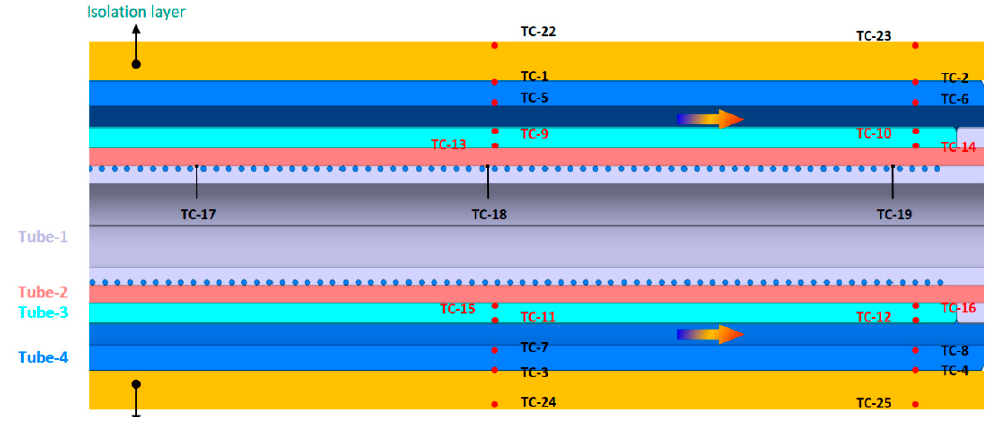
Figure 5. TCs on test section.